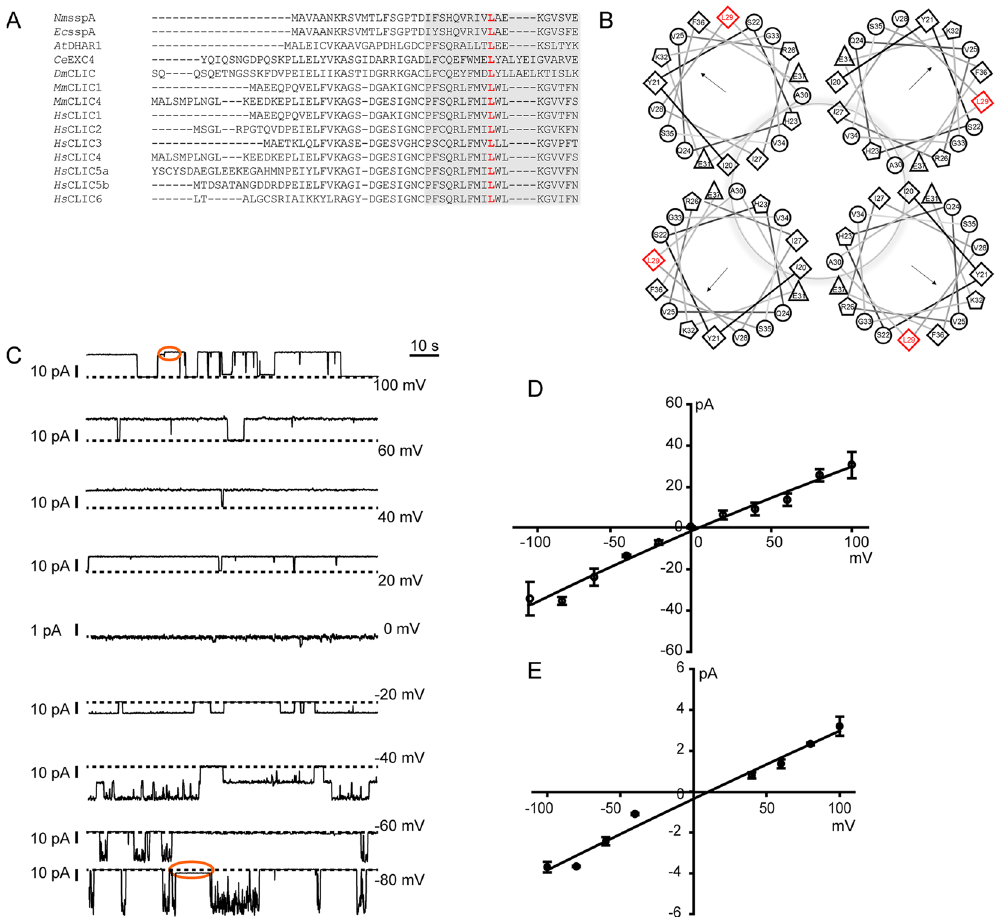
Figure 4. SspA L29A mutants increase the channel conductance. ( A ) Sequence alignment of the N-terminus of prokaryotes ( Nm and Ec ). Plants ( At ), worms ( Ce ), flies ( Dm ), mouse ( Mm ) and Humans ( Hs ) CLICs. Grey area represents the transmembrane domain in the N-terminus. The conserved leucine is represented in red. ( B ) Helical wheel projection of the putative transmembrane domain of Ec SspA. The L29 residue (red diamond) faces the lipid bilayer. Arrows indicate hydrophobic region. ( C ) Representative traces of SspA L29A channel currents at various holding potentials. The dashed line indicates closed levels. Substate levels are indicated by red ovals. ( D ) Current-voltage (I/V) plot of the large channel currents. ( E ) I/V plot of the substate level channel currents of SspA L29A. Reversal potential was found to be ∼ − 3 ± 2 mV for both I/Vs. Error bars represent standard error of the